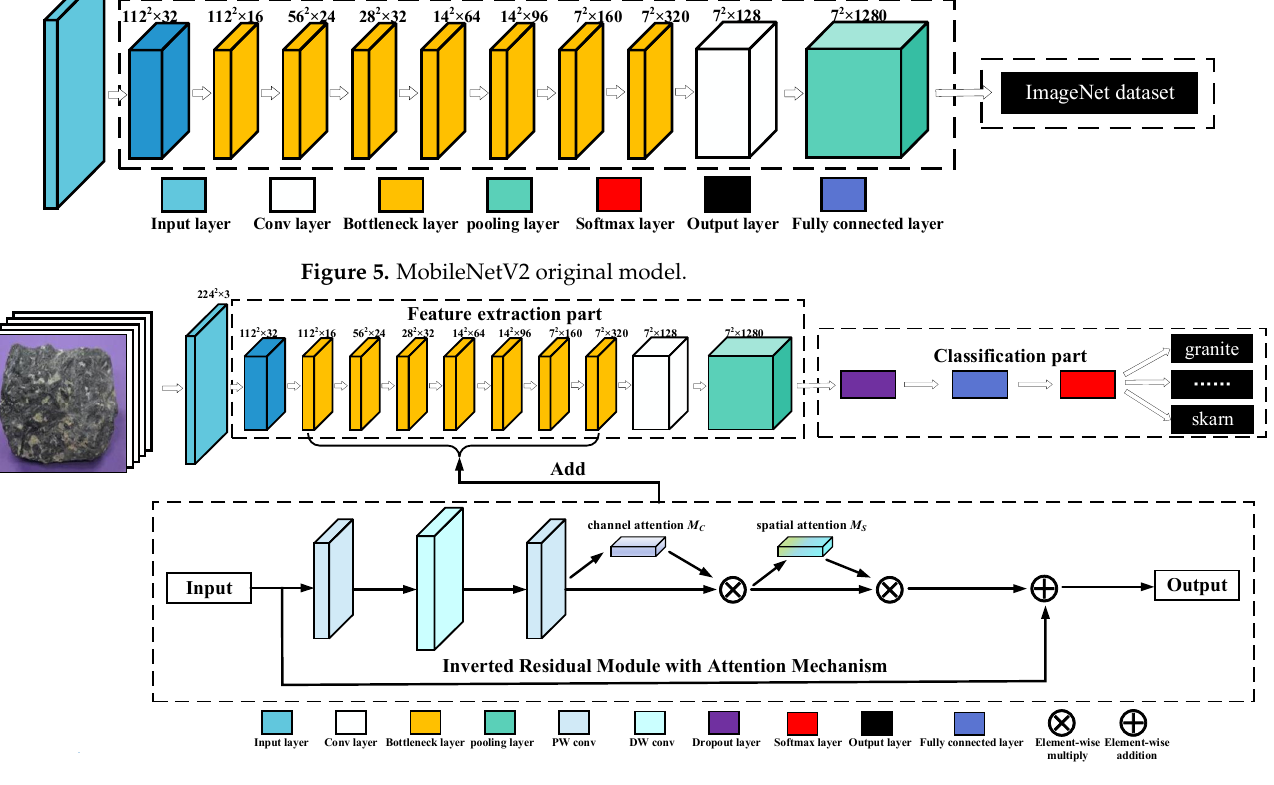
Figure 6. The improved MobileNetV2 lithology recognition model.